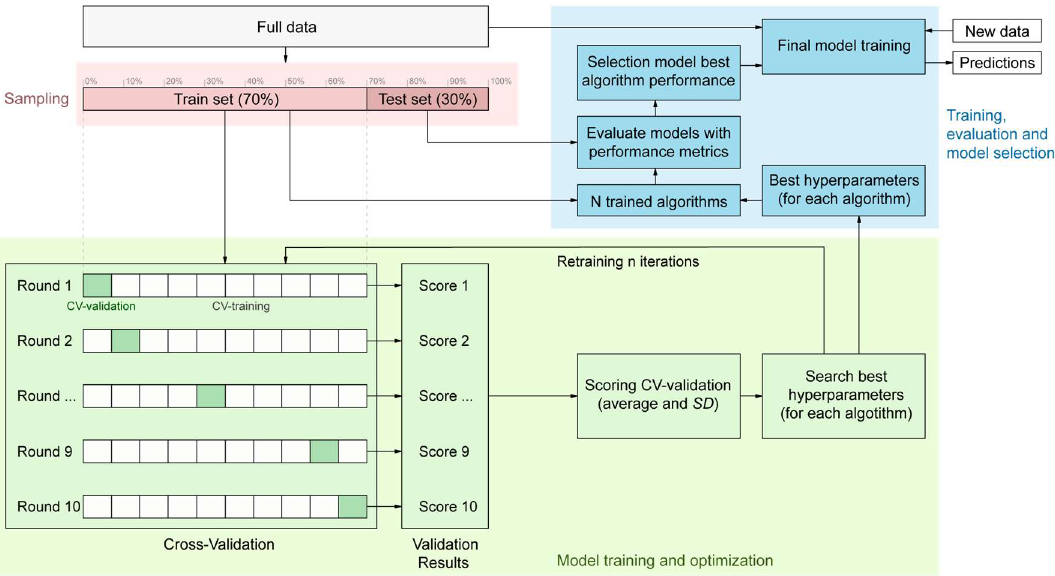
Figure 10. Workflows in the training, optimization, evaluation, and model selection phases.